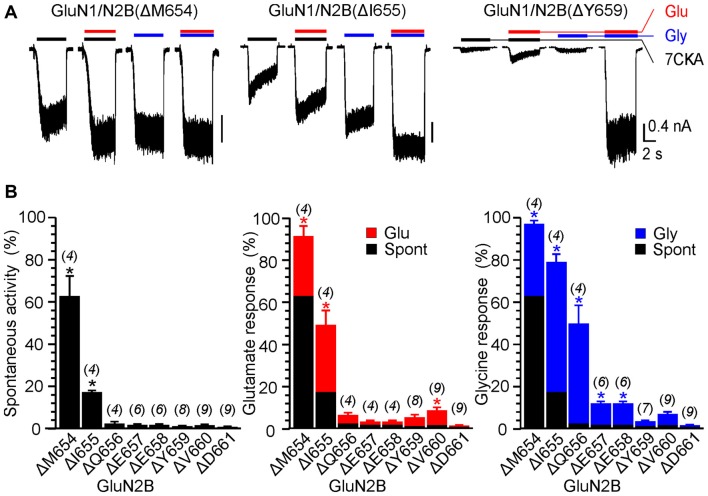
The effect of single-deletion mutations of GluN2B linker on receptor activity. (A) Representative current responses of GluN1/GluN2B(ΔM654), GluN1/GluN2B(ΔI655) and GluN1/GluN2B(ΔY659). Application of ECS containing 7CKA (10 μM) with no added Mg2+, glutamate, or glycine is indicated by a black bar (7CKA); application of 1 mM glutamate and 7CKA (10 μM) with no added Mg2+ or glycine is indicated by a red bar (Glu); application of 0.1 mM glycine with no added Mg2+ or glutamate is indicated by a blue bar (Gly). In between the applications of Mg2+-free ECS, the cells were bathed in ECS containing 2 mM Mg2+. (B) Summary graphs of the mean ± SEM (n) of the relative responses—RISpont (black columns), RIGlu (red columns) and RIGly (blue columns; see Equations 1–3)—in receptors with a single residue deleted in GluN2B. Differences in the relative responses determined for WT and mutated receptors were statistically significant; one-way ANOVA (P < 0.001); followed by multiple comparisons of the relative responses of mutated receptors vs. WT (RISpont 0.44 ± 0.06 (n = 24); RIGlu 0.63 ± 0.30 (n = 24); RIGly 1.1 ± 0.2 (n = 24)); Dunnett’s test; *P < 0.050.